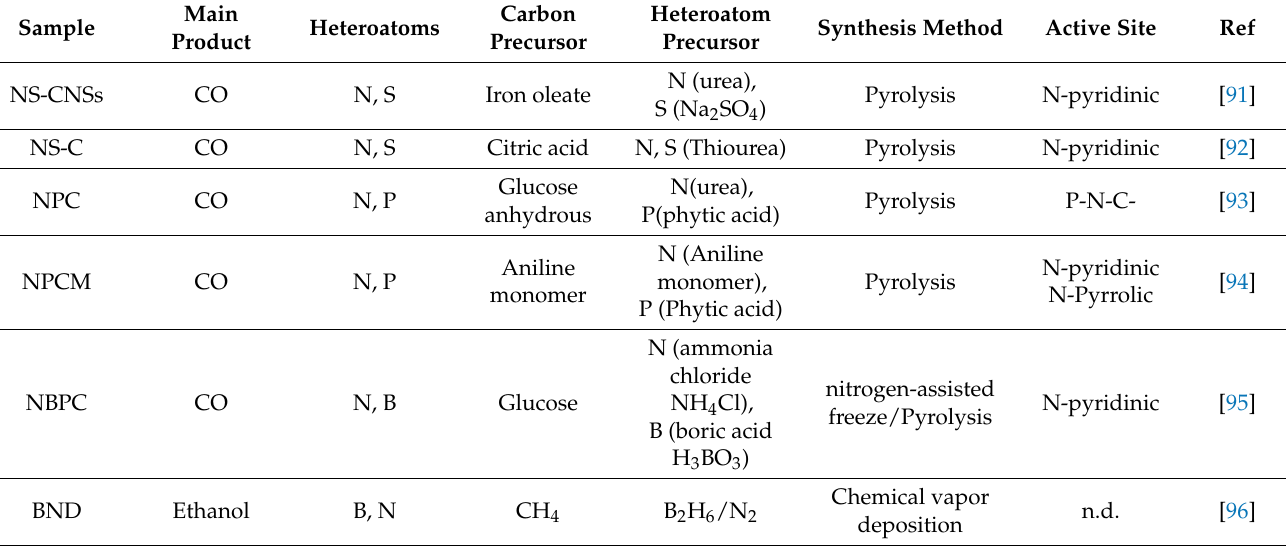
Table 5. Carbon and other precursors of heteroatoms to construction of electrocatalysts and active